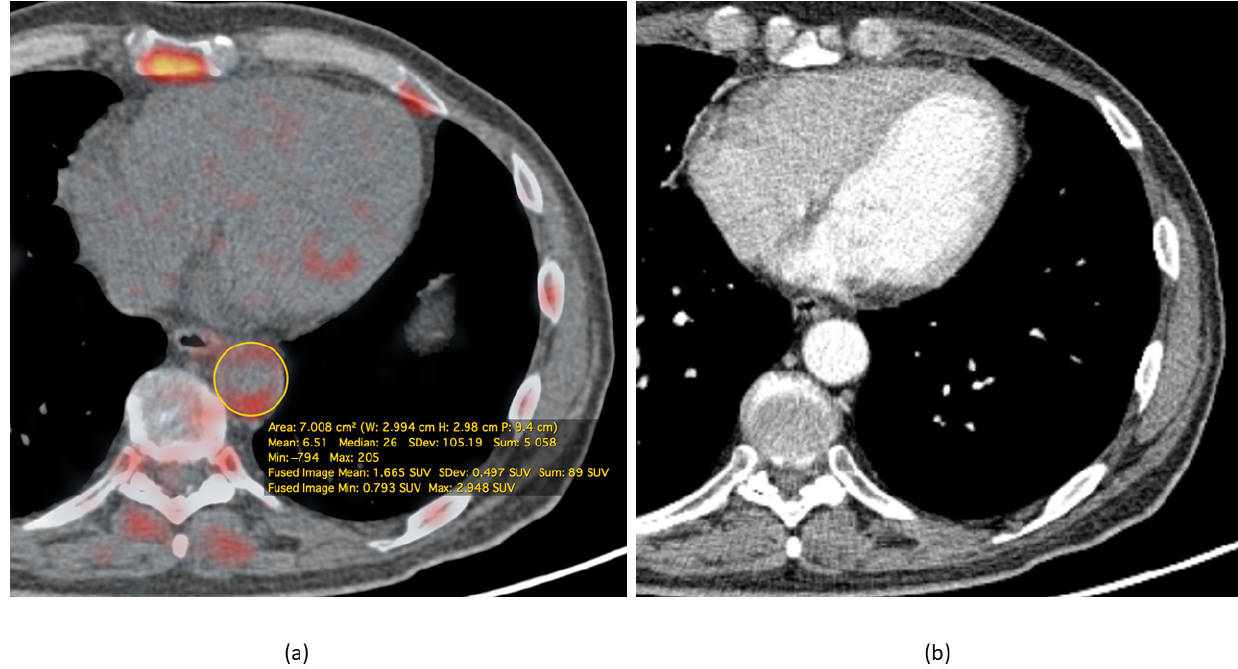
Figure 1. Representative FDG PET/CT of a male 65-year-old patient, diagnosed with small cell lung cancer. The study was performed 60 min after intravenous injection of 185 MBq of FDG. ( a ) Fusion image demonstrates increased FDG uptake in the thoracic descending aorta walls with the maximum standardized uptake value(SUVmax) = 2.9. ( b ) The arterial phase of the contrast-enhanced CT at the corresponding level shows only mild thickening of the vessel wall. These findings suggest an active inflammation process in the vessel walls. All calculations were performed with OsiriX MD (Pixmeo SARL, Bernex, Switzerland).